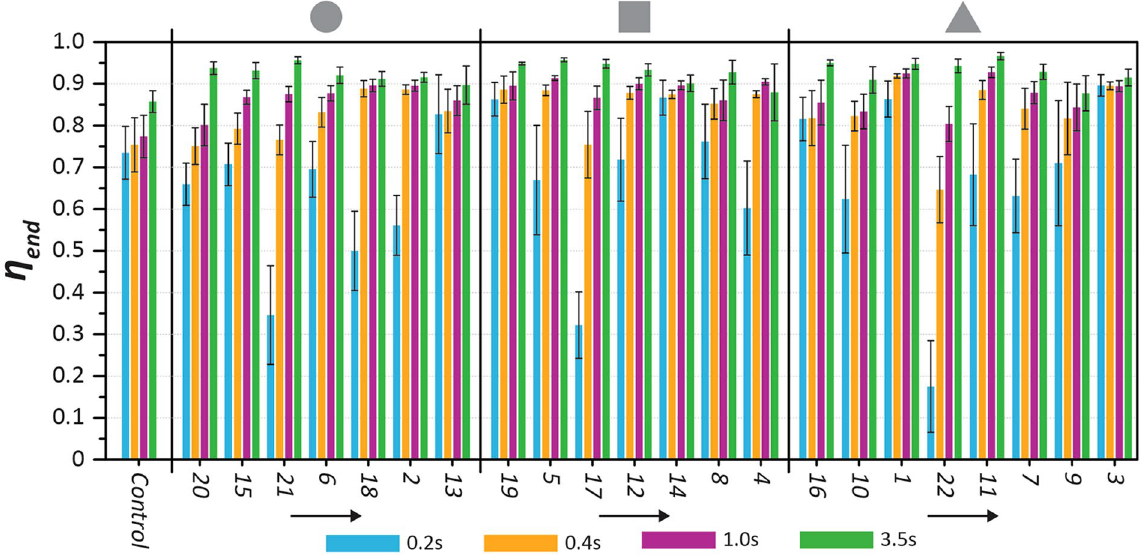
Figure 5. Variation of mixing efficiency ( η end ) with time at the end of the C Wedge domain for each SDSM configuration (see Table 1). SDSM were grouped first according to the respective shape of the superhydrophobic island (denoted at top), and then with increasing probability of island inundation in each group (indicated by black arrows beneath each shape